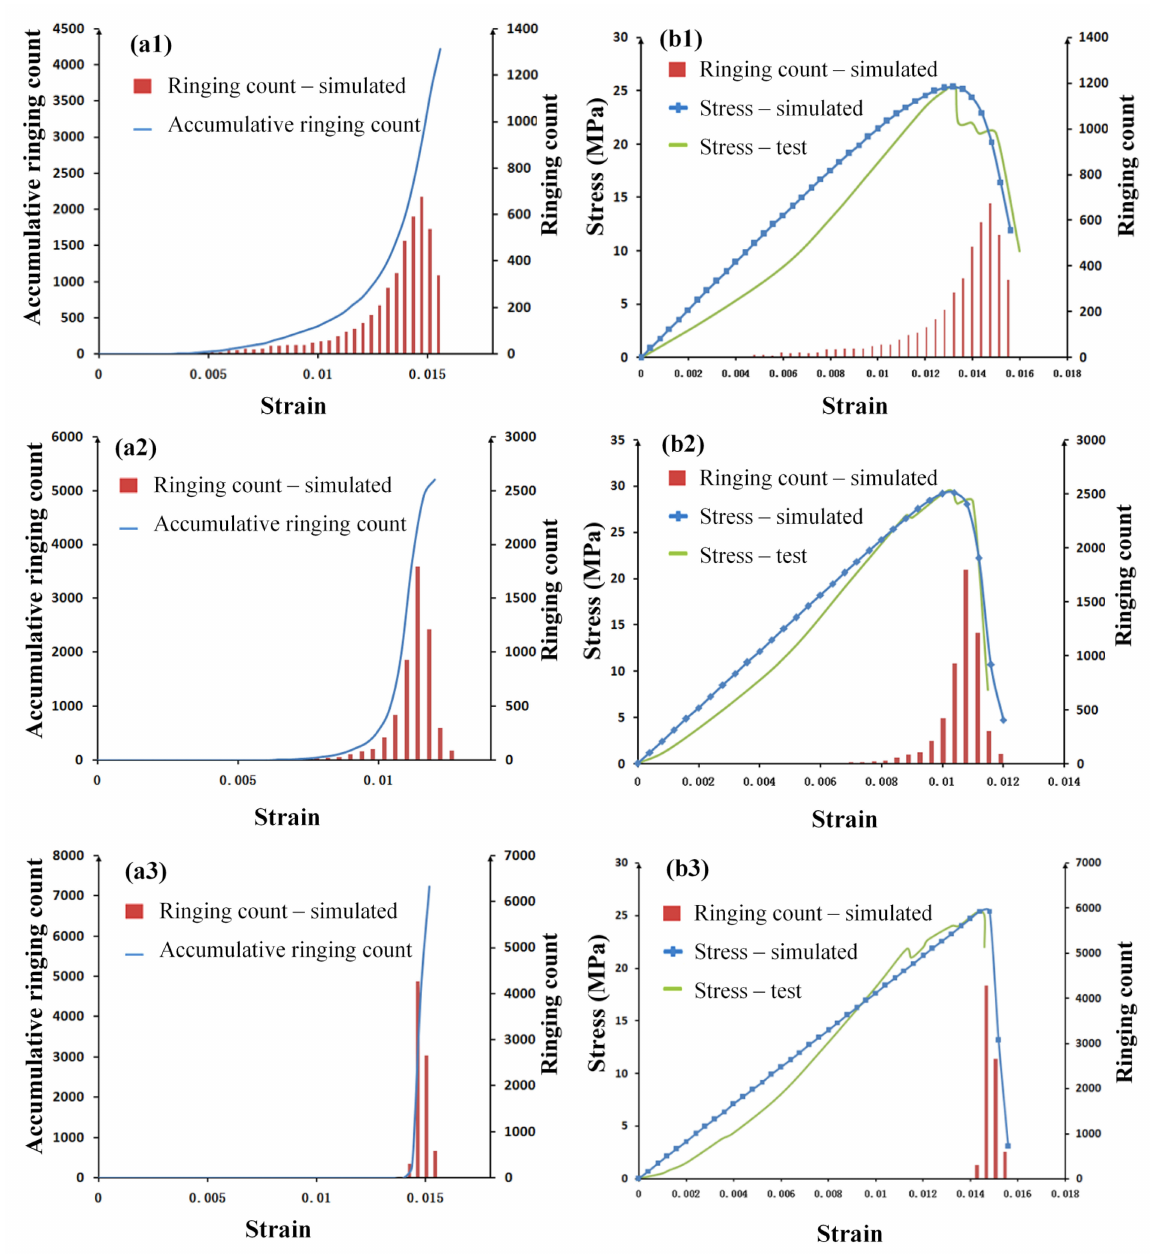
Figure 9. Damage characteristics and stress–strain relationships of red-bed soft rock in uniaxial compression numerical tests. ( a1 ) Accumulative ringing count (No. 1 rock sample); ( a2 ) Accumulative ringing count (No. 2 rock sample); ( a3 ) Accumulative ringing count (No. 3 rock sample); ( b1 ) Stress (No. 1 rock sample); ( b2 ) Stress (No. 2 rock sample); ( b3 ) Stress (No. 3 rock